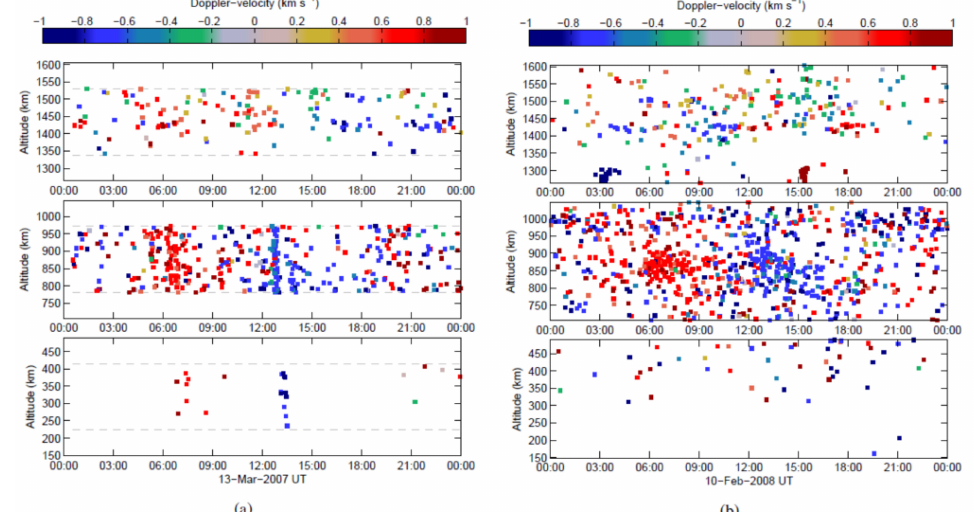
Figure 16. Time–altitude distribution of events at the beginning ( a ) and end ( b ) of the International Polar Year (IPY) campaign performed by the EISCAT Svalbard Radar (ESR) [34]. Reproduced with permission from Markkanen, J., EISCAT Space Debris During the IPY—A 5000 Hour Campaign; 5th ESA Space Debris Conference, Darmstadt, Germany, 30 March-2 April